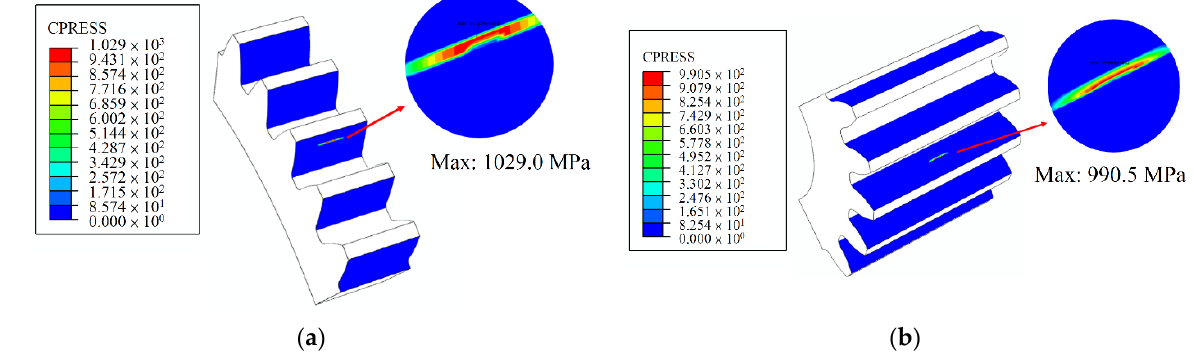
Figure 7. FEA of optimum design under ideal assembly state: ( a ) gear; ( b ) pinion.